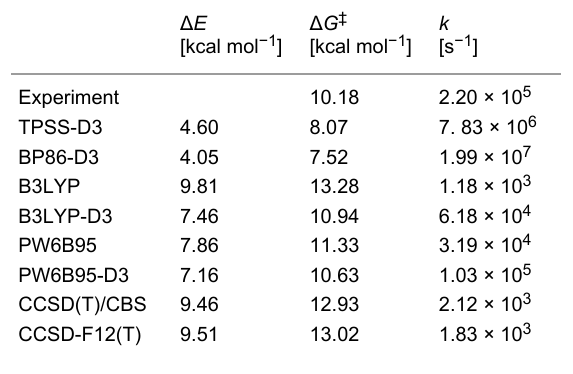
Table 1: Experimental and computed rate constants and free energies of activation of the 5- exo cyclization of the hexenyl radical in benzene at 25